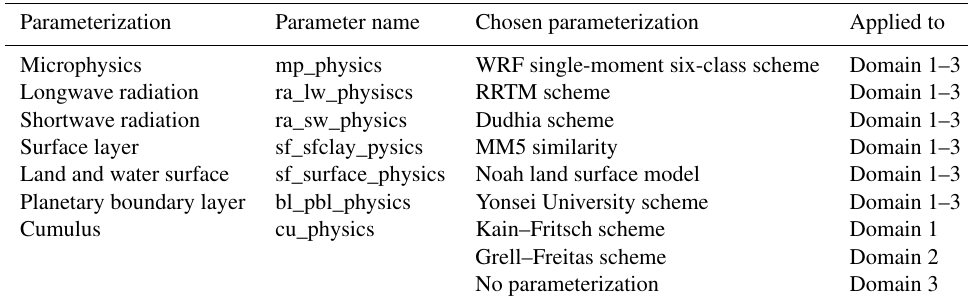
Table 1. Important parameterizations used to run the WRF sensitivity